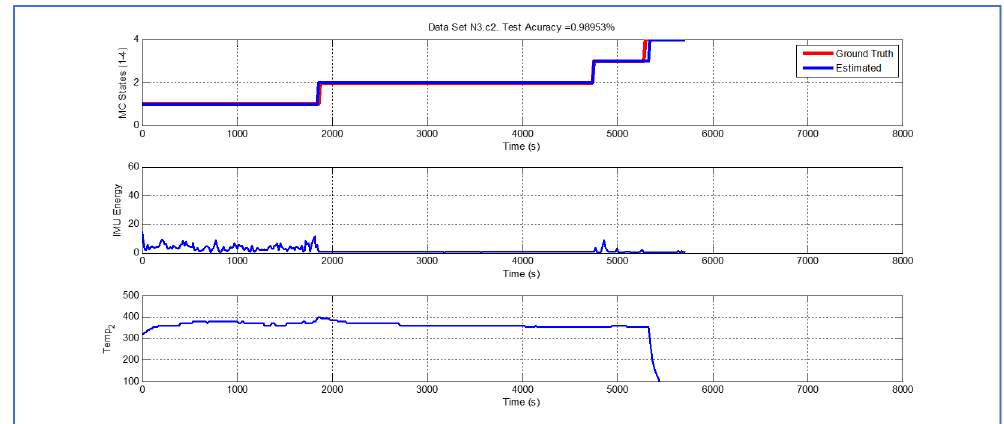
Figure 8. Detection of berry harvesting stages. Dataset N 3 c 2